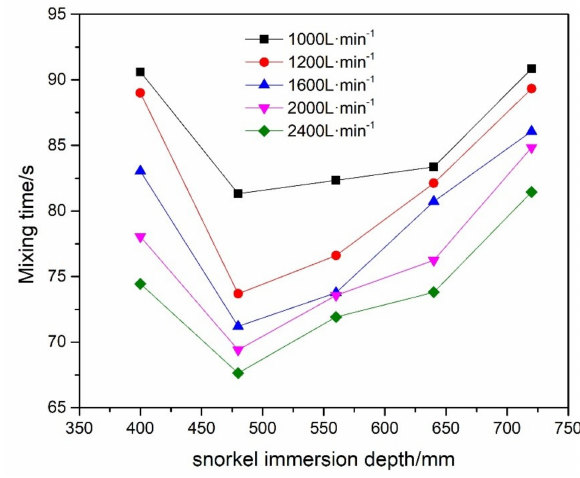
Figure 3. The e ff ect of gas flow rate and SID on mixing